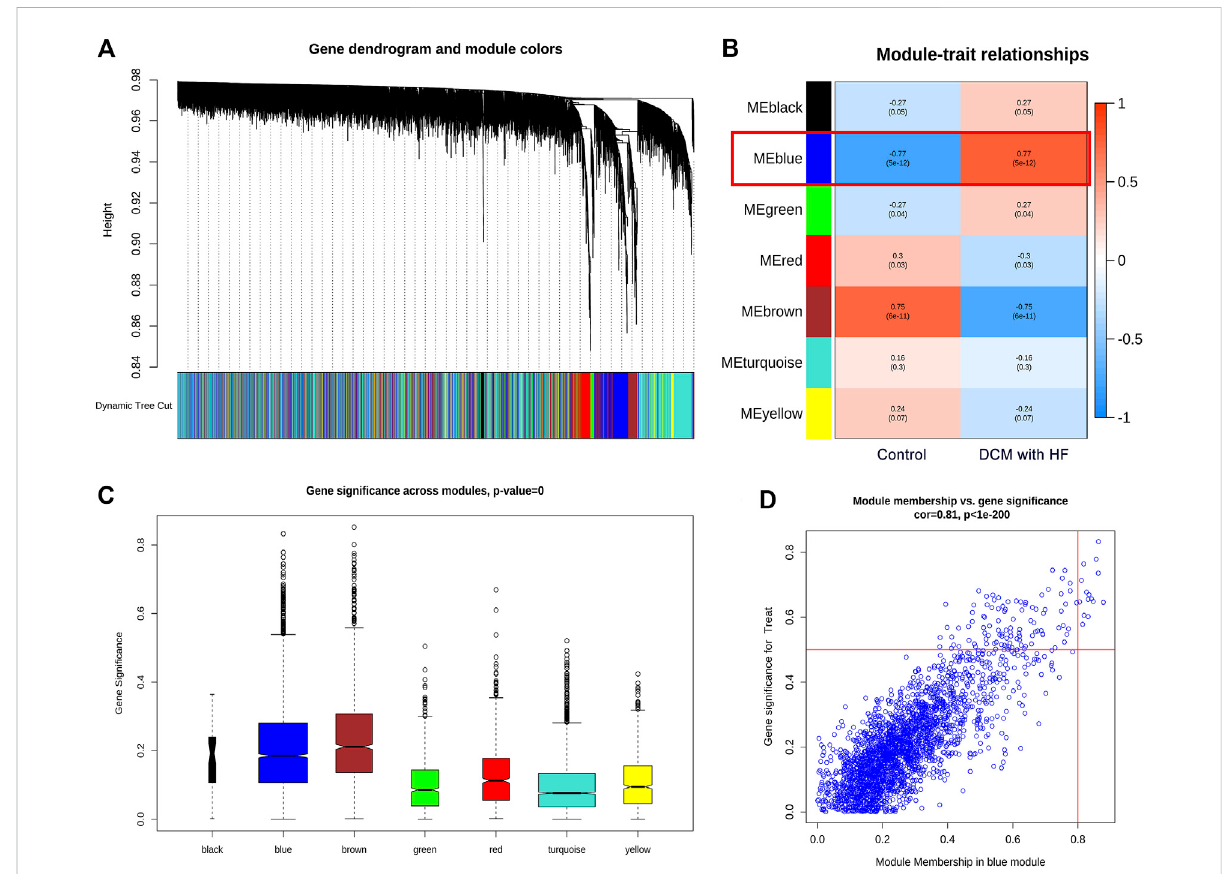
FIGURE 4 Identi fi cation of driver genes in module related to DCM with HF. (A) Dendrogram of all genes with dissimilarity clustered on topological overlap. (B) Correlation of seven modules and two traits (control and DCM with HF). The blue module was signi fi cantly correlated with DCM with HF ( R =0.77, p < 0.001). (C) BoxplotofGeneSigni fi cance(GS)distributionacrosssevenmodules. (D) ScatterplotofModuleMembership(MM)intheblue module versus GS for DCM with